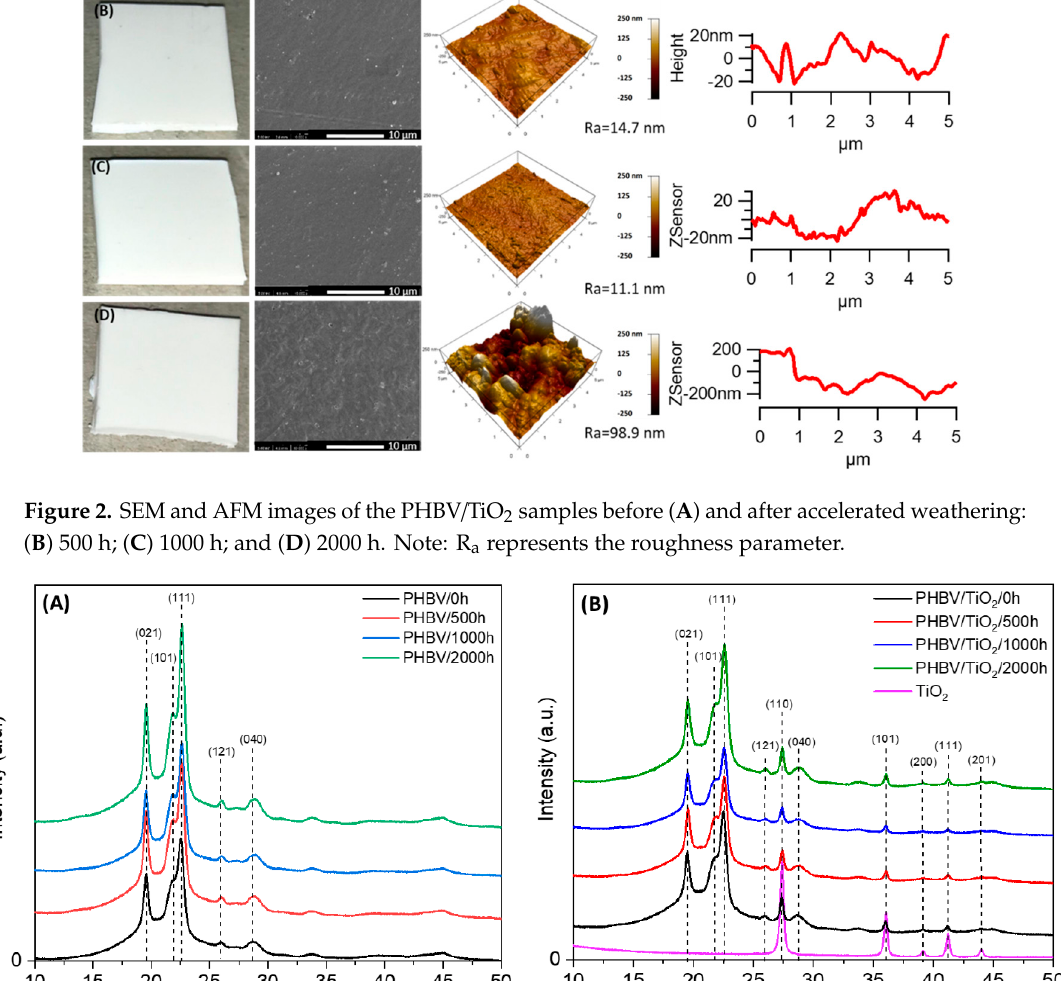
Figure 2. SEM and AFM images of the PHBV/TiO 2 samples before ( A ) and after accelerated weathering: ( B ) 500 h; ( C ) 1000 h; and ( D ) 2000 h. Note: R a represents the roughness parameter.